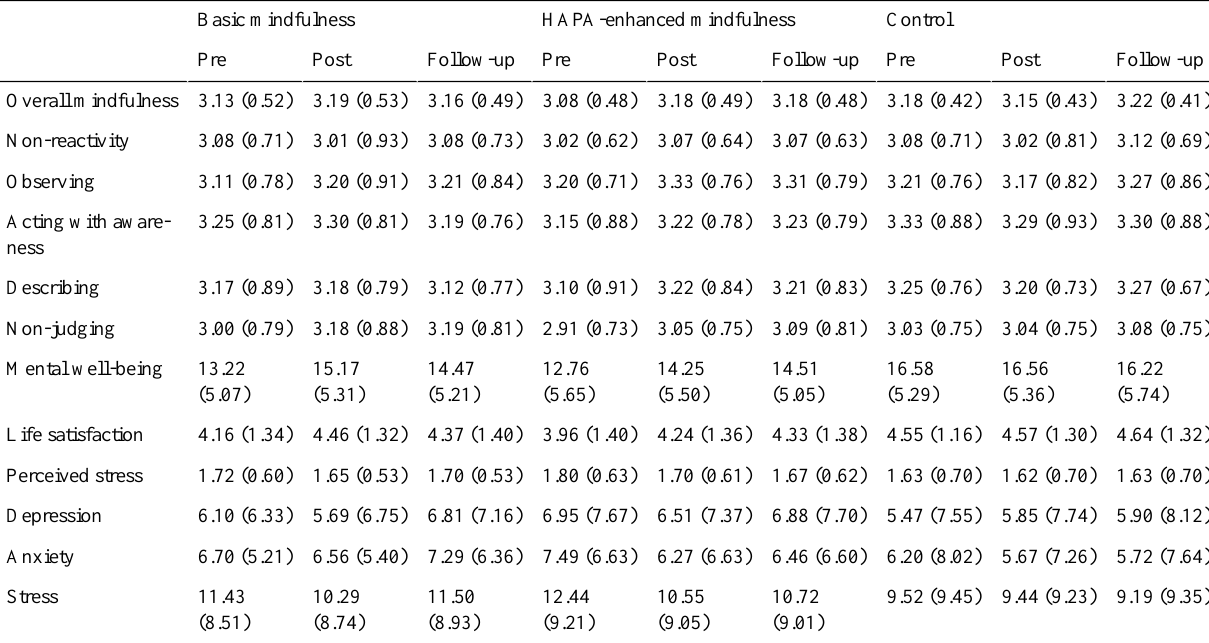
Table 1. Mean (SD) among basic mindfulness, HAPA-enhanced mindfulness, and waitlist control groups on